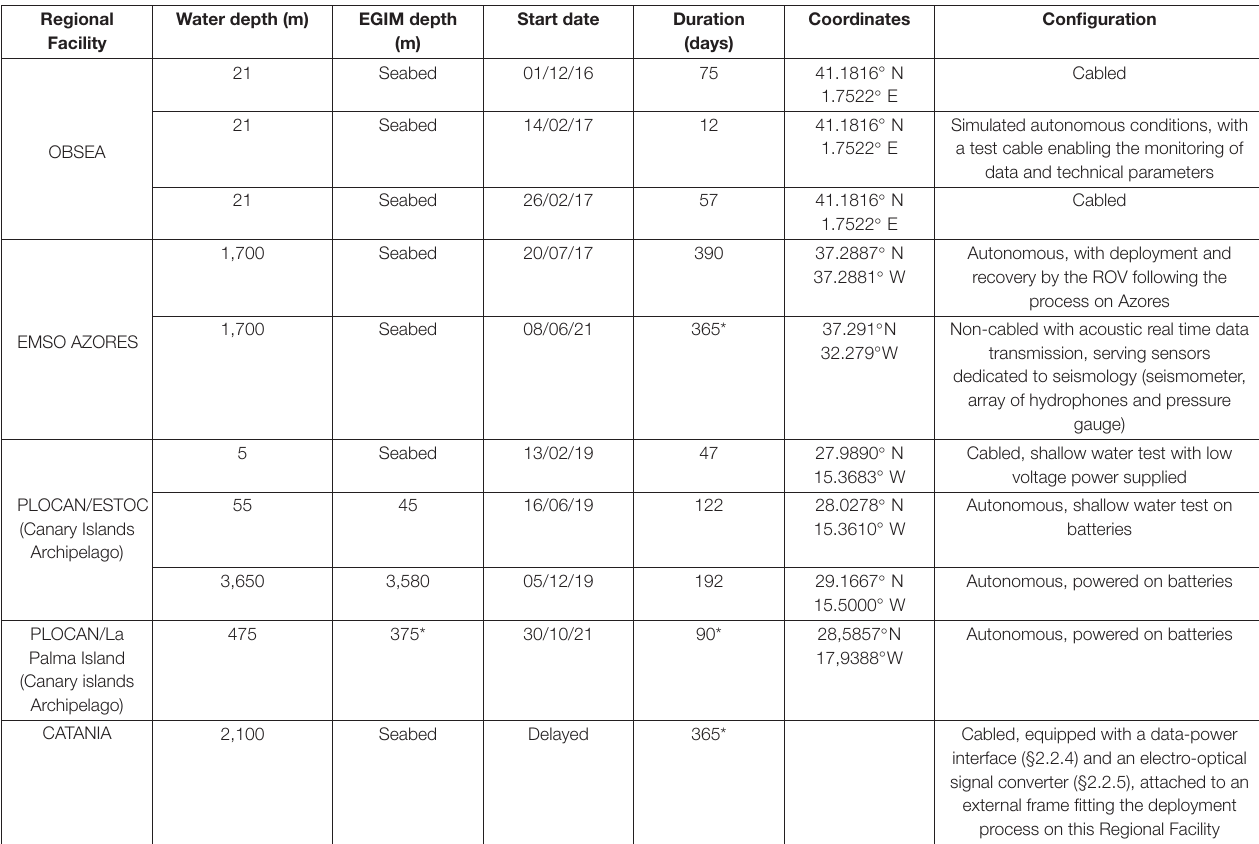
TABLE 2 | EGIM deployments up to date, with information about the EGIM setup; See general description in Figure 2 , §3.1.1 for autonomous or non-cabled modes and §3.1.2 for cabled mode; (*) duration and depth expected for present or coming